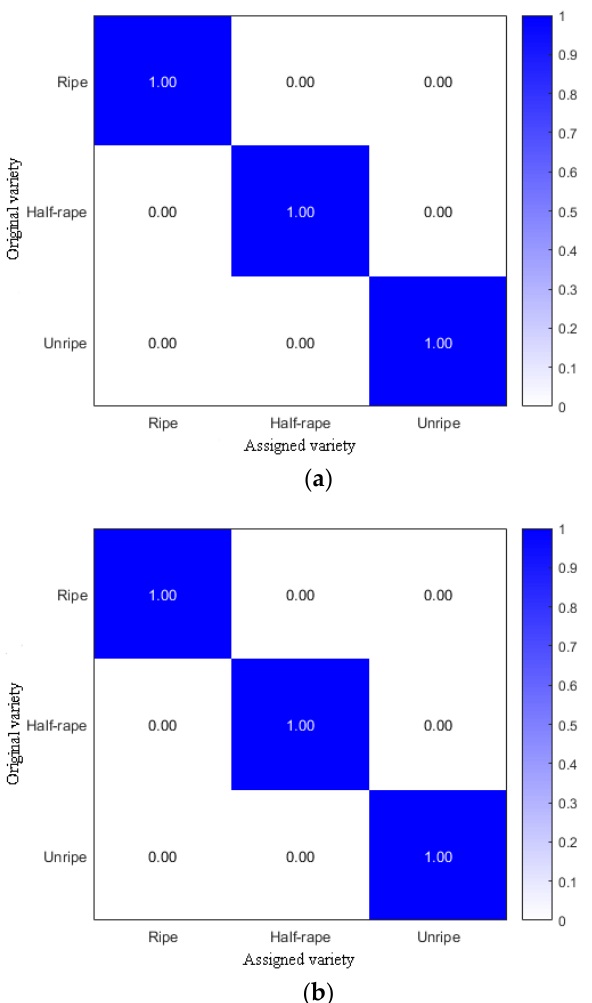
Figure 12. Confusion matrixes of the training set ( a ) and prediction set ( b ).